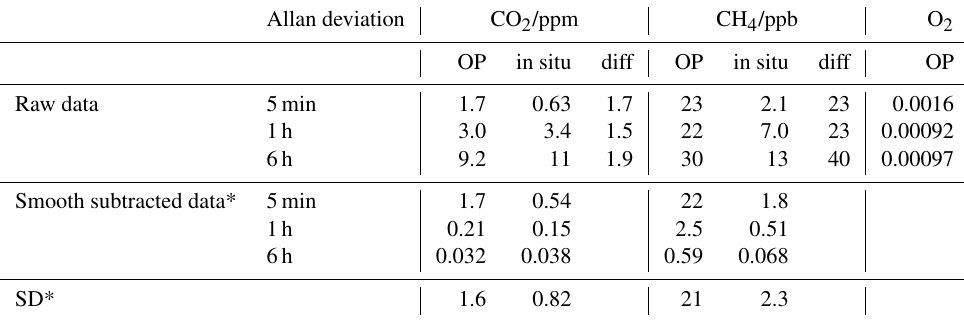
Table 2. Allan deviations for open-path and in situ measurements and their differences. The Allan deviation analysis is taken over the period 11 August, 06:00–27 August, 18:00 when diurnal variations were least. Allan deviation CO 2 /ppm CH 4 /ppb O 2 OP in situ diff OP in situ diff OP Raw data 5min 1.7 1h Smooth subtracted data* 5min